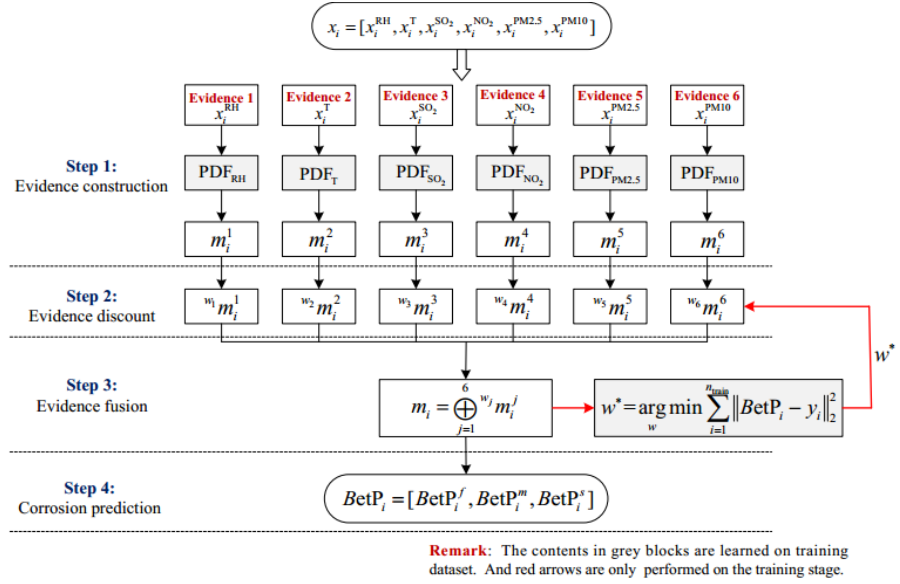
Figure 6. The framework of the proposed model.